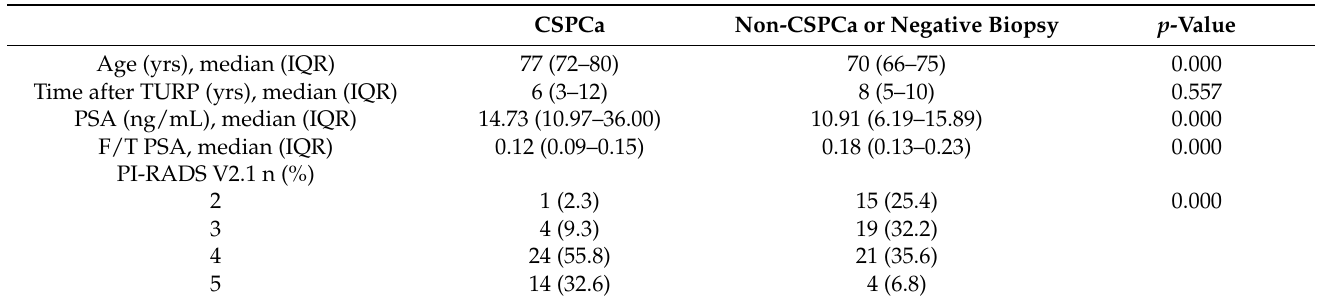
Table 1. Patient characteristics in different biopsy results. CSPCa Non-CSPCa or Negative Biopsy p